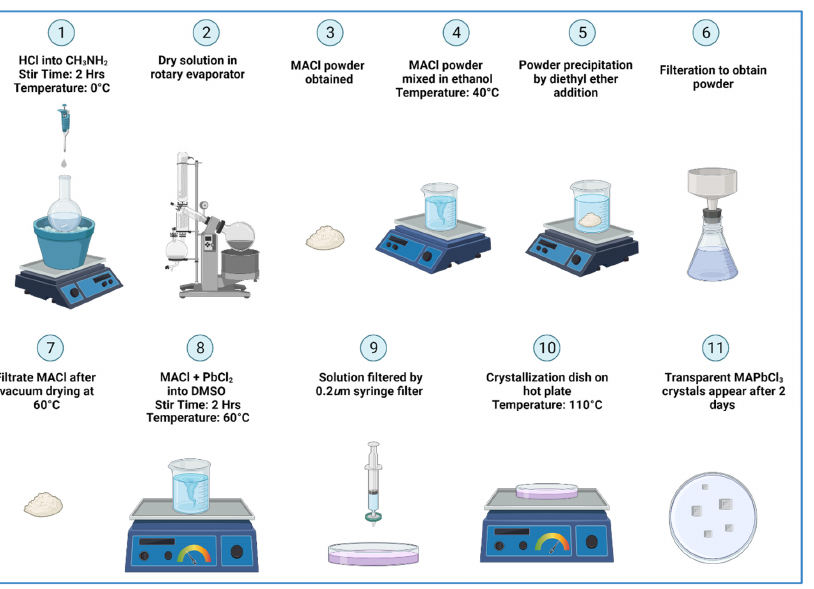
Figure 1. (Color online) A schematic representation of the MAPbCl 3 single crystal growth process based on a solvent evaporation method (created with Biorender.com). In the second step, equimolar solutions of the obtained white MACl powder (1 M, 2.78 g) and PbCl 2 (1 M, 0.58 g) were dissolved in DMSO (10 mL) by stirring at 60 °C. After complete dissolution, the solution was filtered through a 0.22 μ m syringe filter into a crys ‐ tallization dish. The dish was covered with aluminum foil, and a few holes were punched in the foil for slow evaporation resulting in better crystallization. The dish was then kept undisturbed at a constant temperature of 100 °C for 1–2 days. After 1–2 days, transparent MAPbCl 3 crystals were obtained with approximate dimensions of 5 × 4 × 2 mm 3 . The crys ‐ tals were then cleaned with acetone and dried overnight in a vacuum oven at 60 °C. 2.3. Characterization Techniques A standard Raman spectrometer (LabRam HR800, Horiba Co., Longjumeau, France) was used to perform the Raman measurements. The single crystal was excited by using a diode ‐ pumped solid ‐ state laser with a wavelength of 532 nm. The probed frequency range was from 10 to 3500 cm − 1 . The Raman spectrometer was equipped with a low ‐ frequency notch filter, by which the lowest frequency limit could be 10 cm − 1 . All measurements were taken by using an optical microscope (BX41, Olympus Co., Tokyo, Japan) with a 50 ‐ mag ‐ nification objective lens at a backscattering geometry 𝑐 ( 𝑎,𝑎 (cid:3397) 𝑏 ) 𝑐 , where the a , b , and c denote the cubic axes. The scattered light is collected concurrently along the same path as that of the incident light in this geometry. A silicon standard sample with a single peak at 520 cm − 1 was used to calibrate the Raman spectrometer before recording measurements. The measurements were performed at a temperature ranging from − 196 °C to room tem ‐ perature (RT) by using a cryostat (Linkam THMS600,Linkam Scientific Instruments Ltd., Surrey, UK) with a temperature stability of 0.1 °C. One and a half minutes of waiting time were given to reach the thermal equilibrium after the target temperature was achieved for